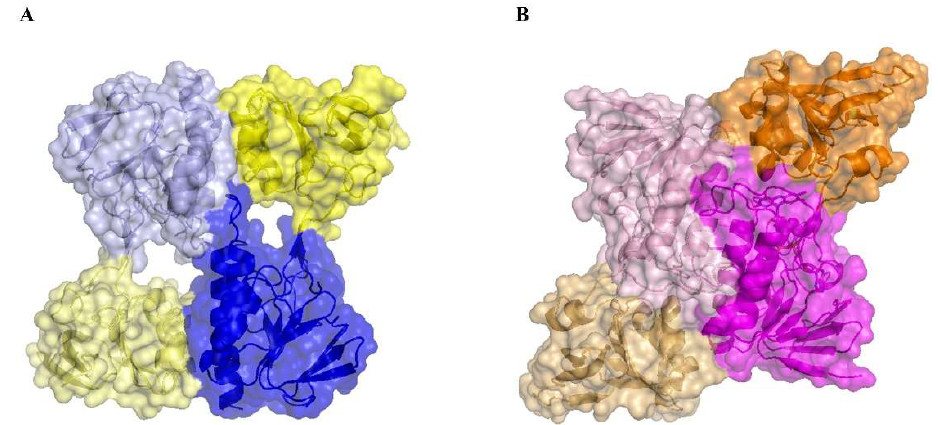
Figure 4. A structural comparison of the homodimer interface in ( A ) MmNTR, with the FAD- and NADPH-binding domains in blue and yellow, respectively; and ( B ) EcNTR (PDB code 1TRB), with the FAD- and NADPH-binding domains in magenta and orange, respectively. The interaction between the two monomers within the crystal lattice buries 1696.9 Å 2 in MmNTR versus 2735.2 Å 2 in EcNTR of protein